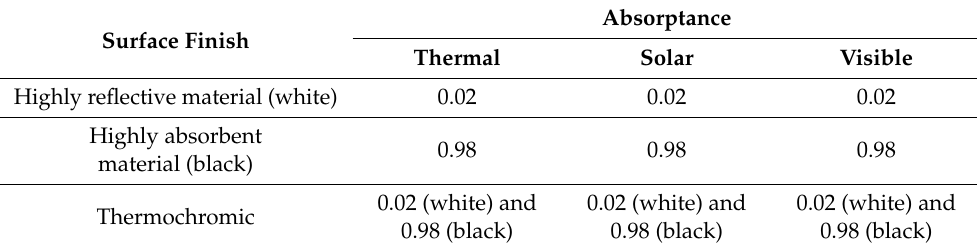
Table 3. Solar absorptance of different